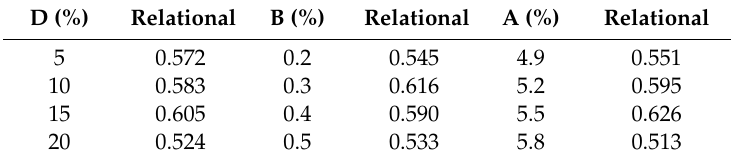
Table 10. Average relevance degree between levels of each factor and object